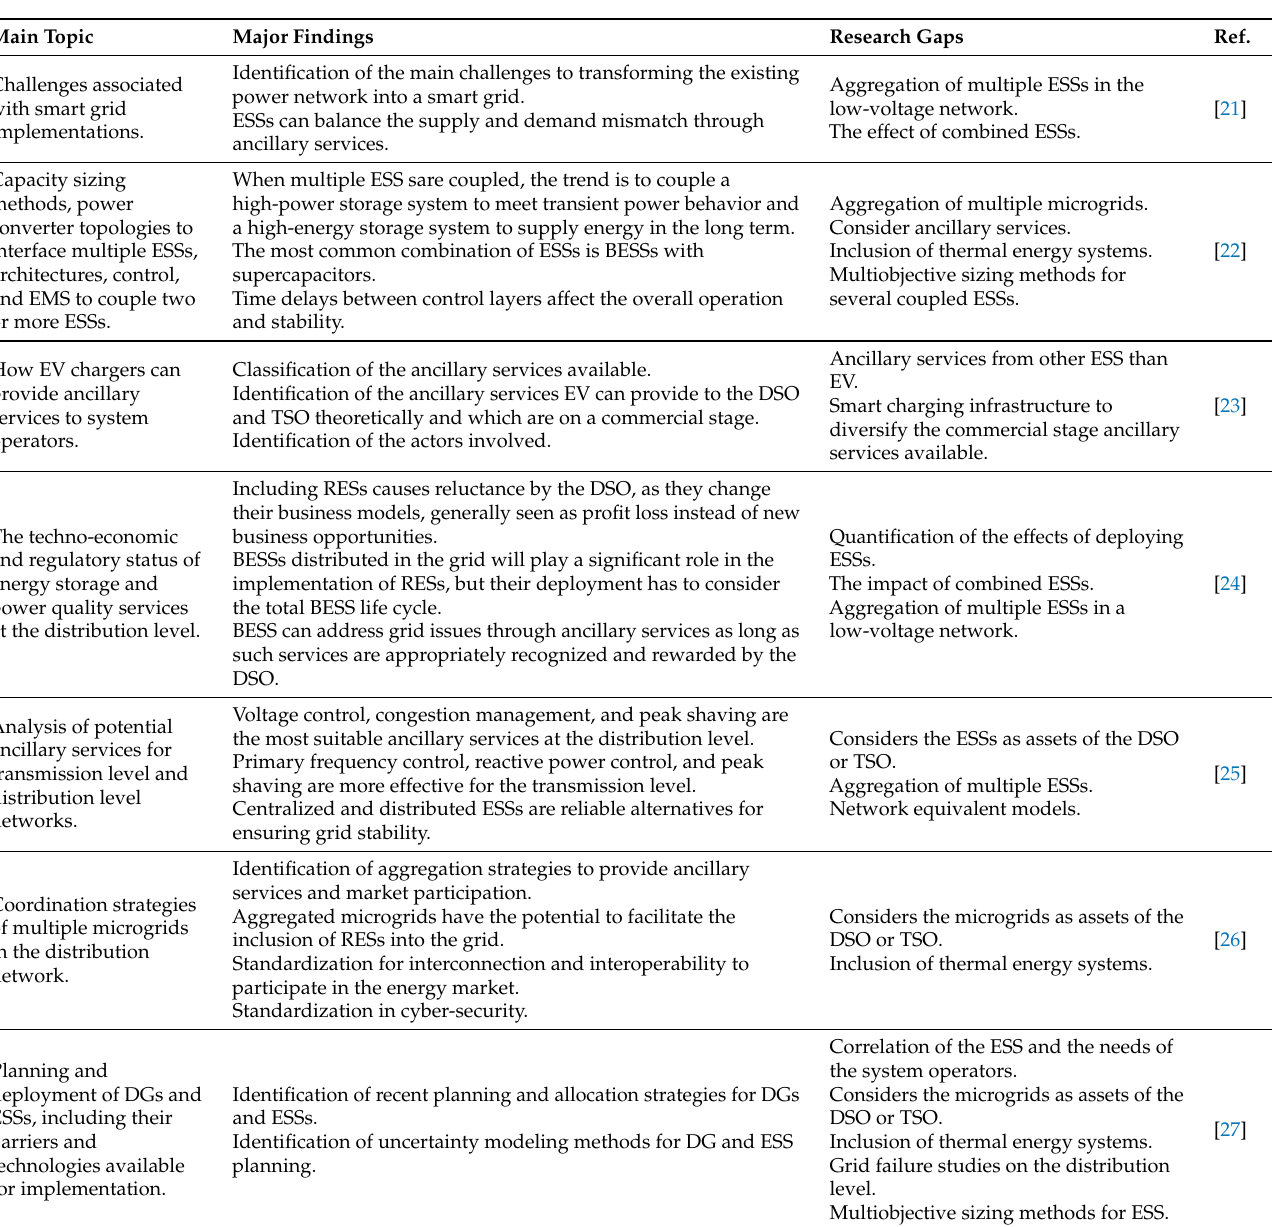
Table 1. Findings and research gaps of recent